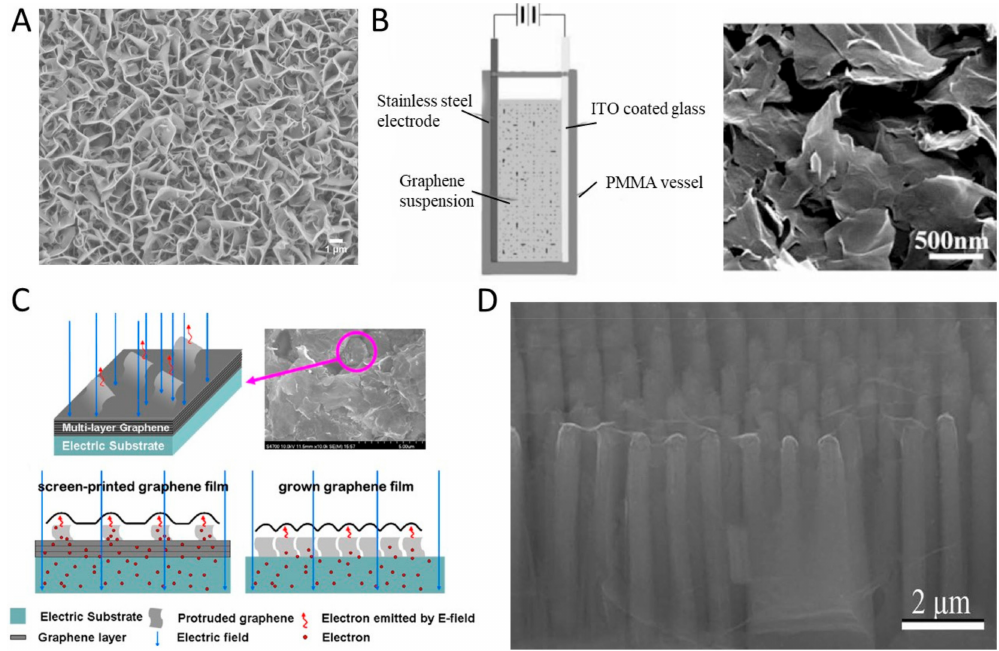
Figure 3. SEM images of microfabricated graphene film emitters. ( A ) Top view SEM micrograph of